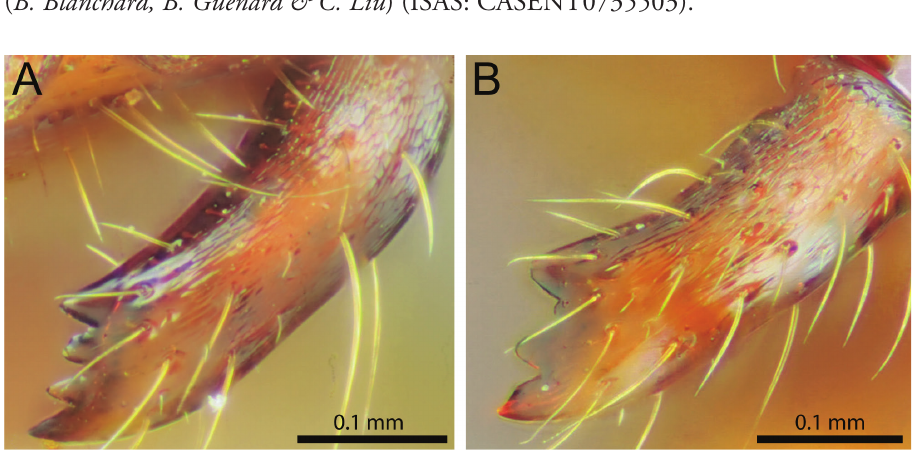
Figure 1. Mandible showing masticatory margin. A A. maneerati Jaitrong & Yamane B A. watanasiti Jaitrong & Yamane. Images are from Jaitrong and Yamane (2013).